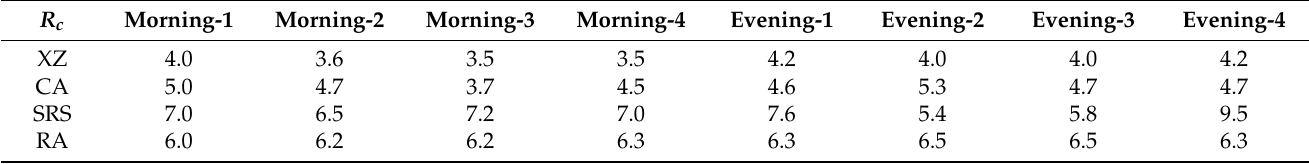
Table 3. The critical perturbation threshold at different times.